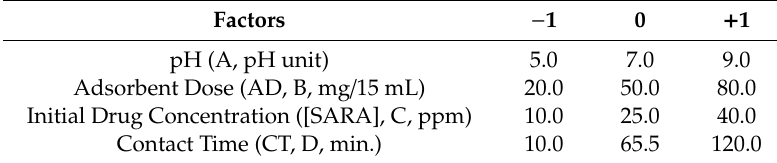
Table 3. Assessed factors together with their upper ( + 1), lower ( − 1) and